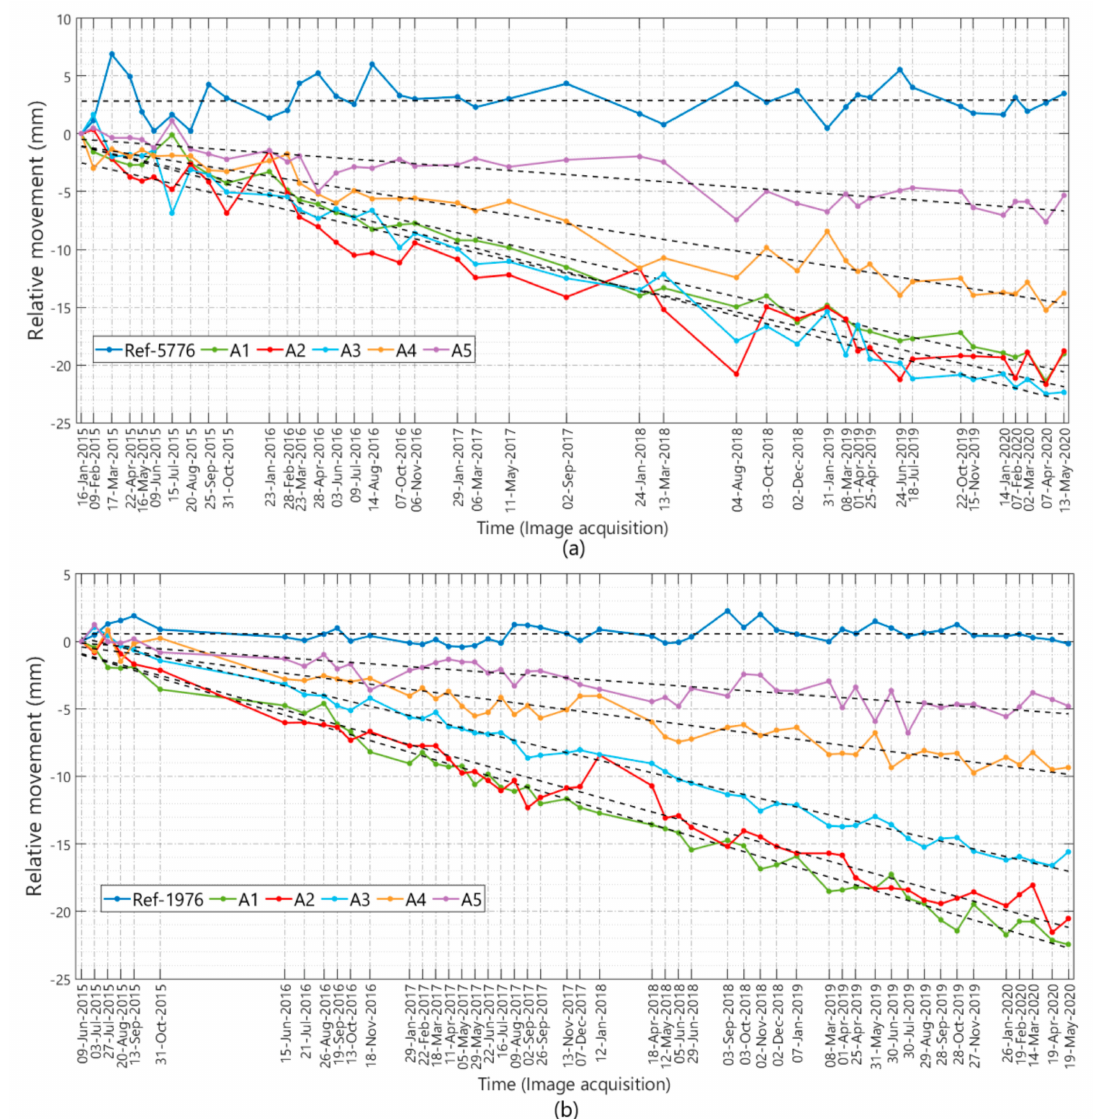
Figure 5. Time series of the selected five areas (i.e., A1–A5), see Figures 3 and 4, where the permanent scatterers (PS) rates have been averaged for ( a ) the ascending, ( b ) the descending, and the references ID 5776 and ID 1976, respectively. The period is between January 2015–May 2020 and June 2015–May